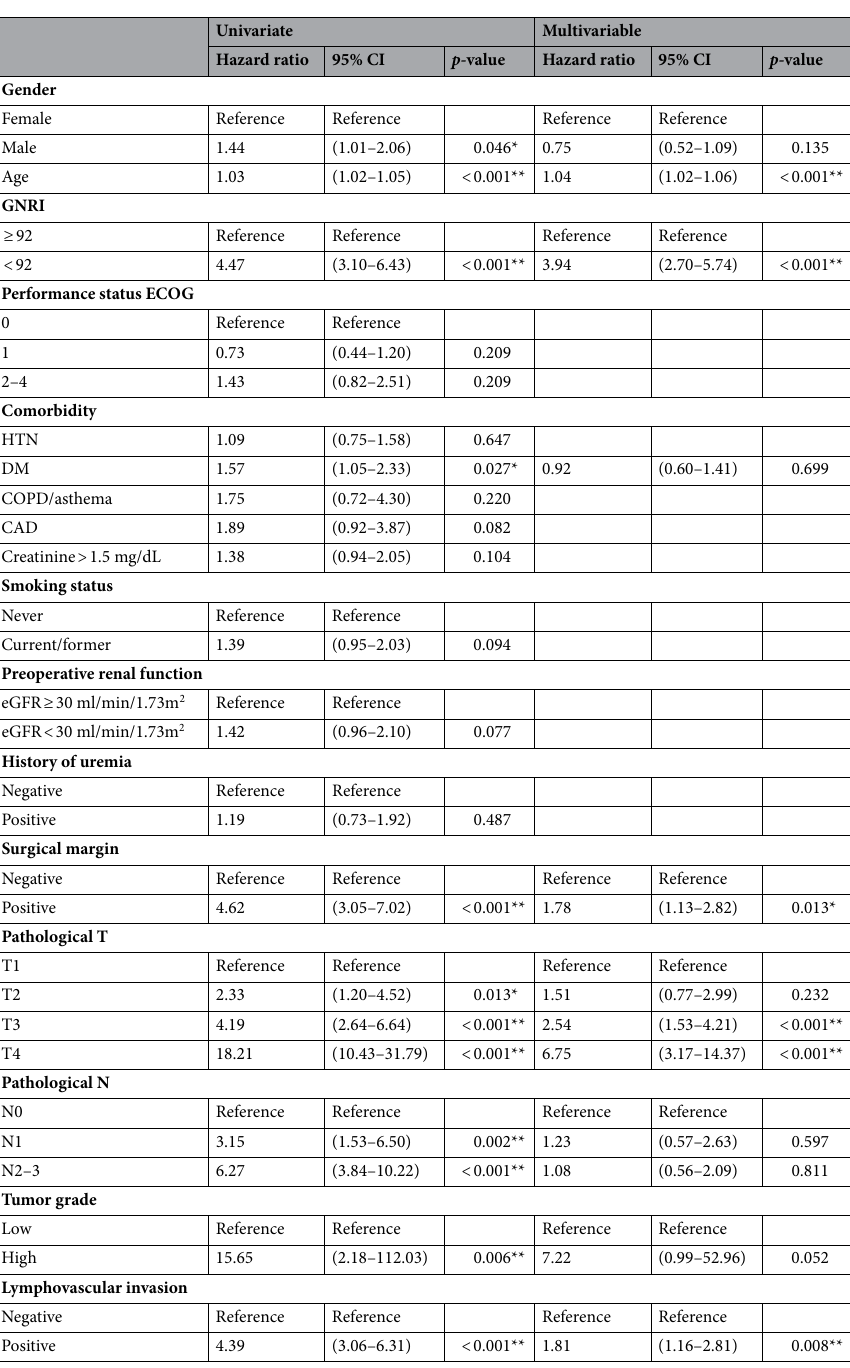
Table 3. Cox regression—overall survival. GNRI geriatric nutritional risk index, ECOG Eastern Cooperative Oncology Group, HTN hypertension, DM diabetes mellitus, COPD chronic obstructive pulmonary disease, CAD coronary artery disease, eGFR estimated Glomerular filtration rate. Cox proportional hazard regression. * p < 0.05, ** p <